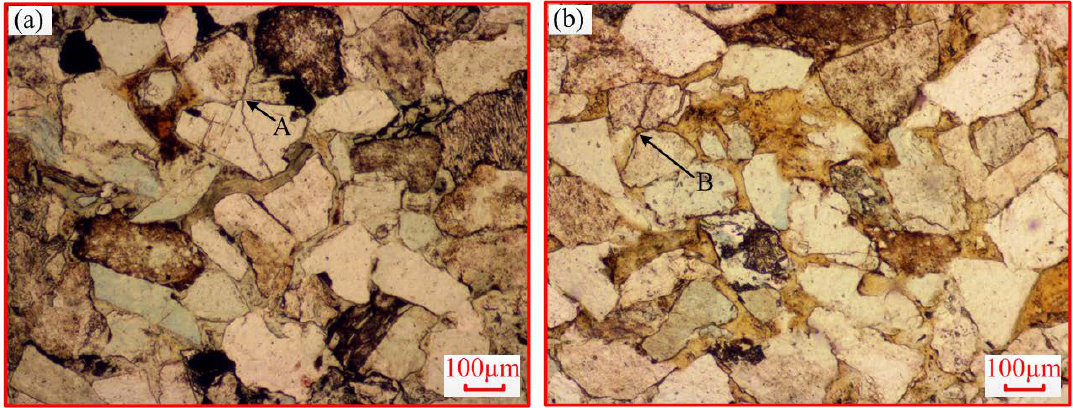
Figure 12. Cracks distribution in the axial direction during the creep tests. The grains, A and B, are crushed by the transgranular cracks as a result of the point of stress concentration at the boundary of the grains. ( a , b ) stand for different locations of cracks distribution in the